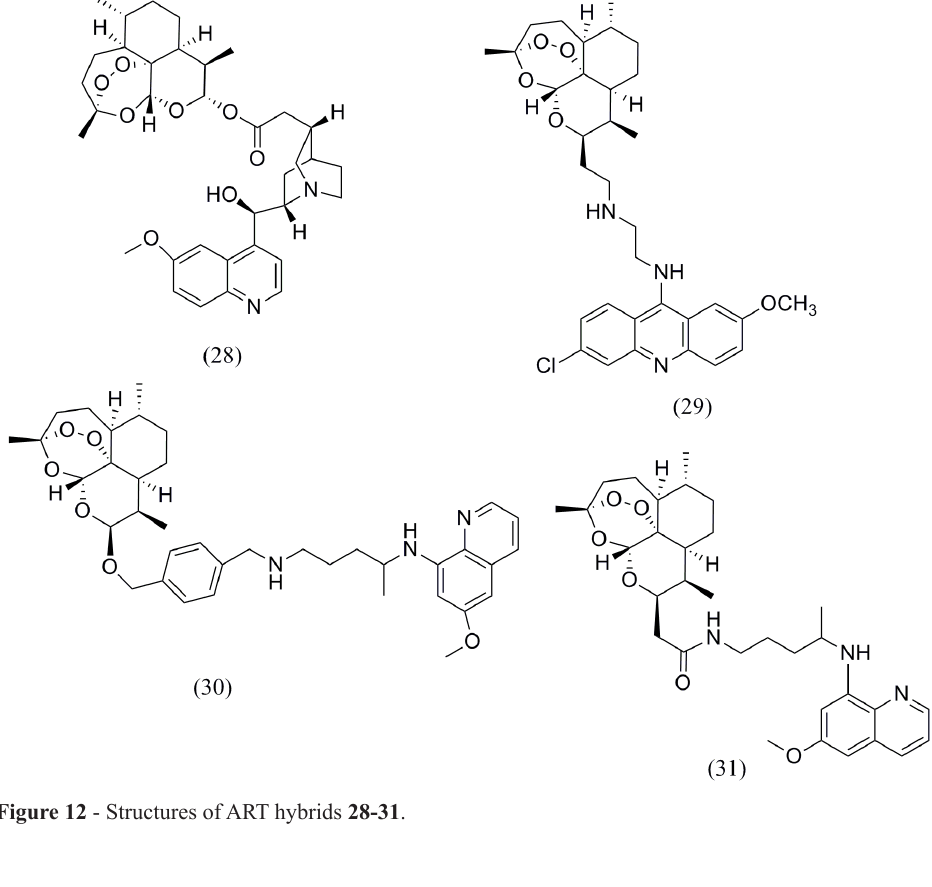
Figure 12 - Structures of ART hybrids 28-31 .